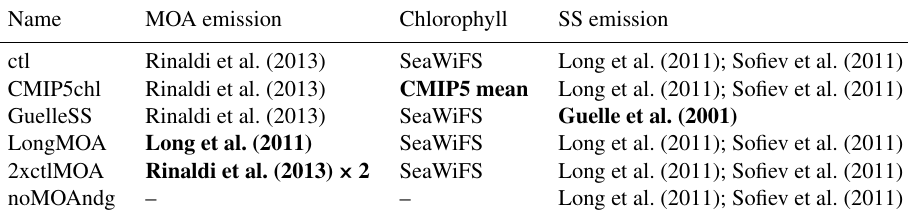
Table 2. List of nudged simulations. In bold are fields which are changed from the control (ctl) set-up. Fields marked with dashes (–) are not relevant for the set-up. “CMIP5chl” uses the chlorophyll concentration from CMIP5 models; “GuelleSS” replaces the SS emission parame- terisation by Guelle et al. (2001); “LongMOA” replaces the Rinaldi et al. (2013) MOA emission by Long et al. (2011); for “2xctlMOA”, the control MOA emission is scaled up by two times; and lastly, MOA is not emitted in the “noMOAndg” simulation.